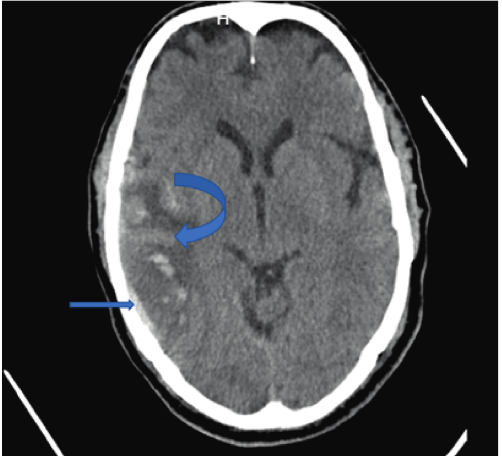
Figure 1: First brain CTscan showing cortical vein thrombosis (inferior anastomosis vein) (rectus arrow) with right temporal infarction in which transformation to hemorrhage occurs (curved arrow).